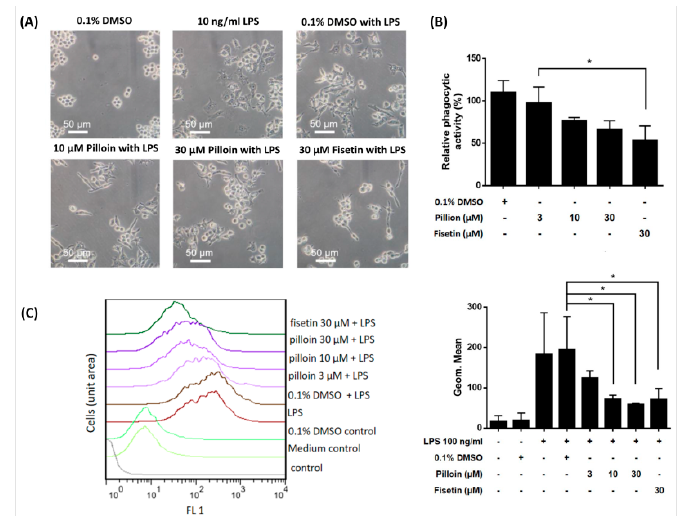
Figure 4. Pilloin suppresses morphological alterations and decreases phagocytic activity in LPS ‐ stimulated RAW 264.7 macrophages. ( A ) Pilloin attenuates morphological alterations induced by LPS. RAW 264.7 macrophages (10 5 cells in MP ‐ 6 plates) were treated with pilloin or 0.1% DMSO for 1 h, followed by LPS (10 ng/mL) for 24 h. Images were taken under a phase ‐ contrast microscope. ( B ) Pilloin reduces the phagocytic activity of macrophages. RAW 264.7 macrophages (2 × 10 5 cells in MP ‐ 24 plates) were treated with pilloin or 0.1% DMSO for 24 h, and the fluorescence intensity (480 nm/520 nm) was detected using Infinite ® 200 PRO. The relative phagocytic activity of vehicle and pilloin ‐ treated RAW 264.7 cells was determined based on their fluorescence intensity versus that of untreated cells. ( C ) Pilloin inhibits ROS generation induced by LPS. RAW 264.7 macrophages (5 × 10 5 cells in MP ‐ 6 plates) were treated with pilloin or 0.1% DMSO for 1 h, followed by LPS (100 ng/mL) for 24 h. Fisetin served as the positive control. * indicates a significant difference versus the control group ( p < 0.05).